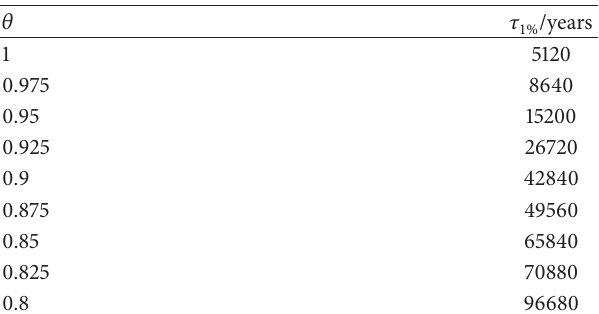
Table 2: Relaxation time.